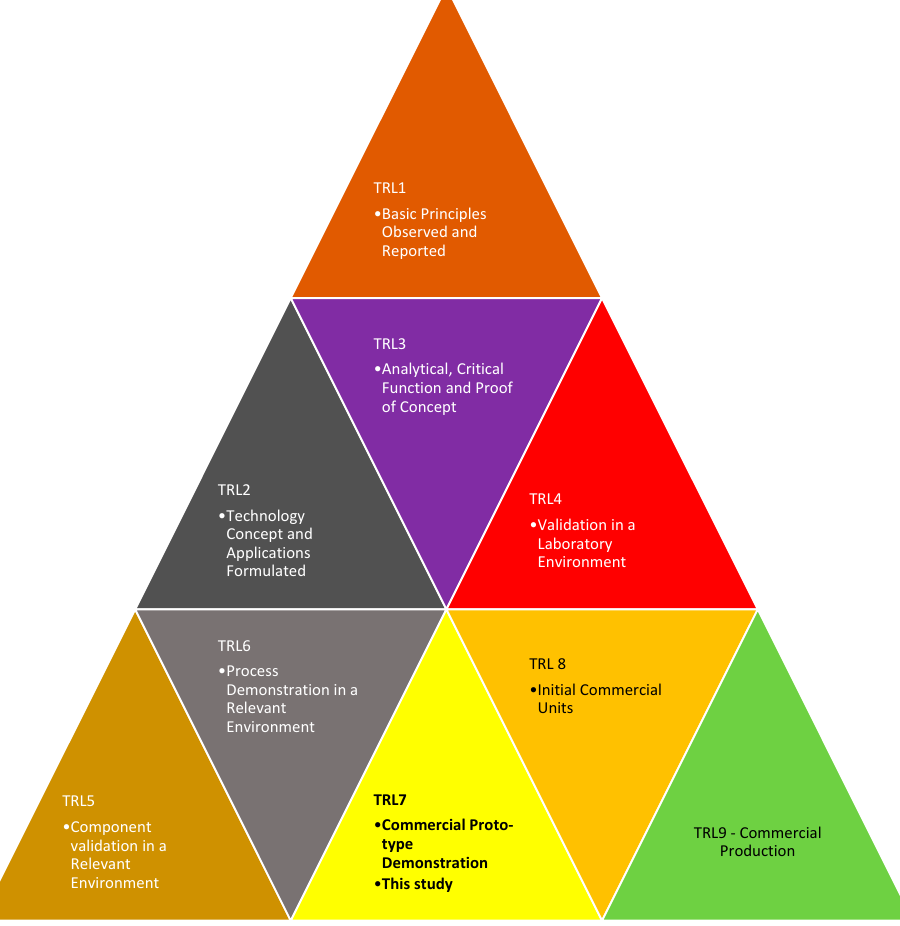
Figure A4. Technology readiness levels associated with zero-valent iron desalination research in diffusion reactors. This study is an initial TRL7 demonstration of a batch flow, bubble column, static bed, diffusion reactor operation (Figure A3). Patents [US9624113B2; US9828258B2; US2018/0009678A] have demonstrated a TRL7 operation for a batch flow, emulsified bubble column, fluidised bed reactor (Figure A3). It is possible that unpublished TRL7 demonstrations have been undertaken for a continuous flow, contact flow, fluidised bed reactor (Figure A3) and a continuous flow, fluidised bed, recirculating reactor (Figure A3).